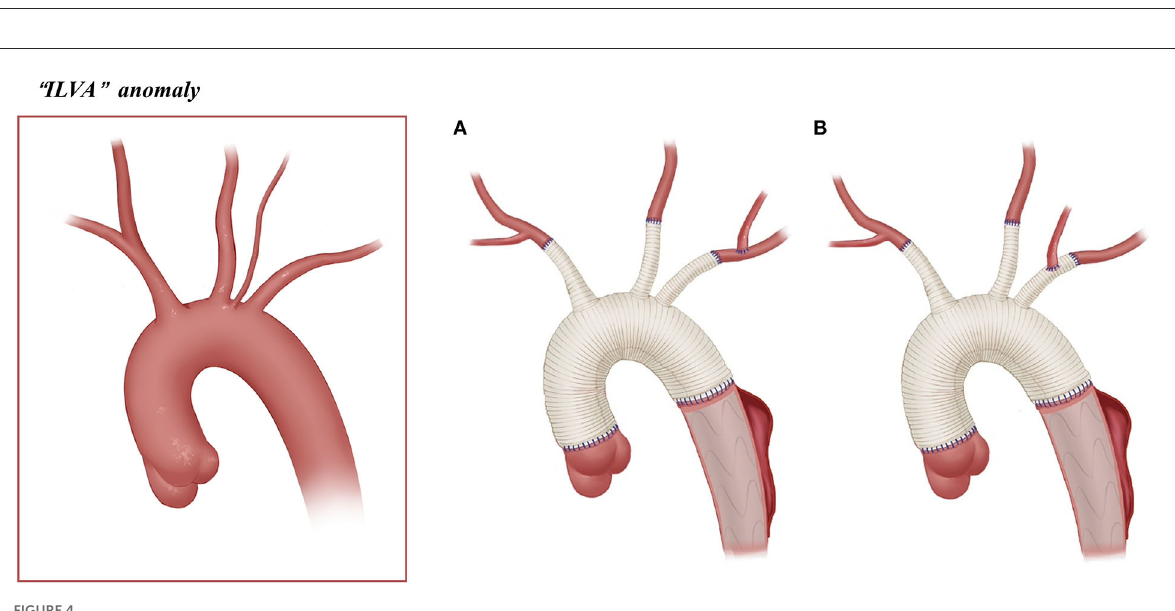
Among 22 patients with an ILVA, 21 underwent SCP. The SCP strategy in these patients is as follows: BiACP ( n = 6) and RUACP ( n = 10) were achieved through cannulation of the right axillary artery/IA with/without the LCCA, and LUACP ( n = 5) was achieved through the cannulation of the LCCA. Only one patient with a right-sided arch combining the ALSA was first operated with femoral artery cannulation for CPB and then RCCA cannulation for